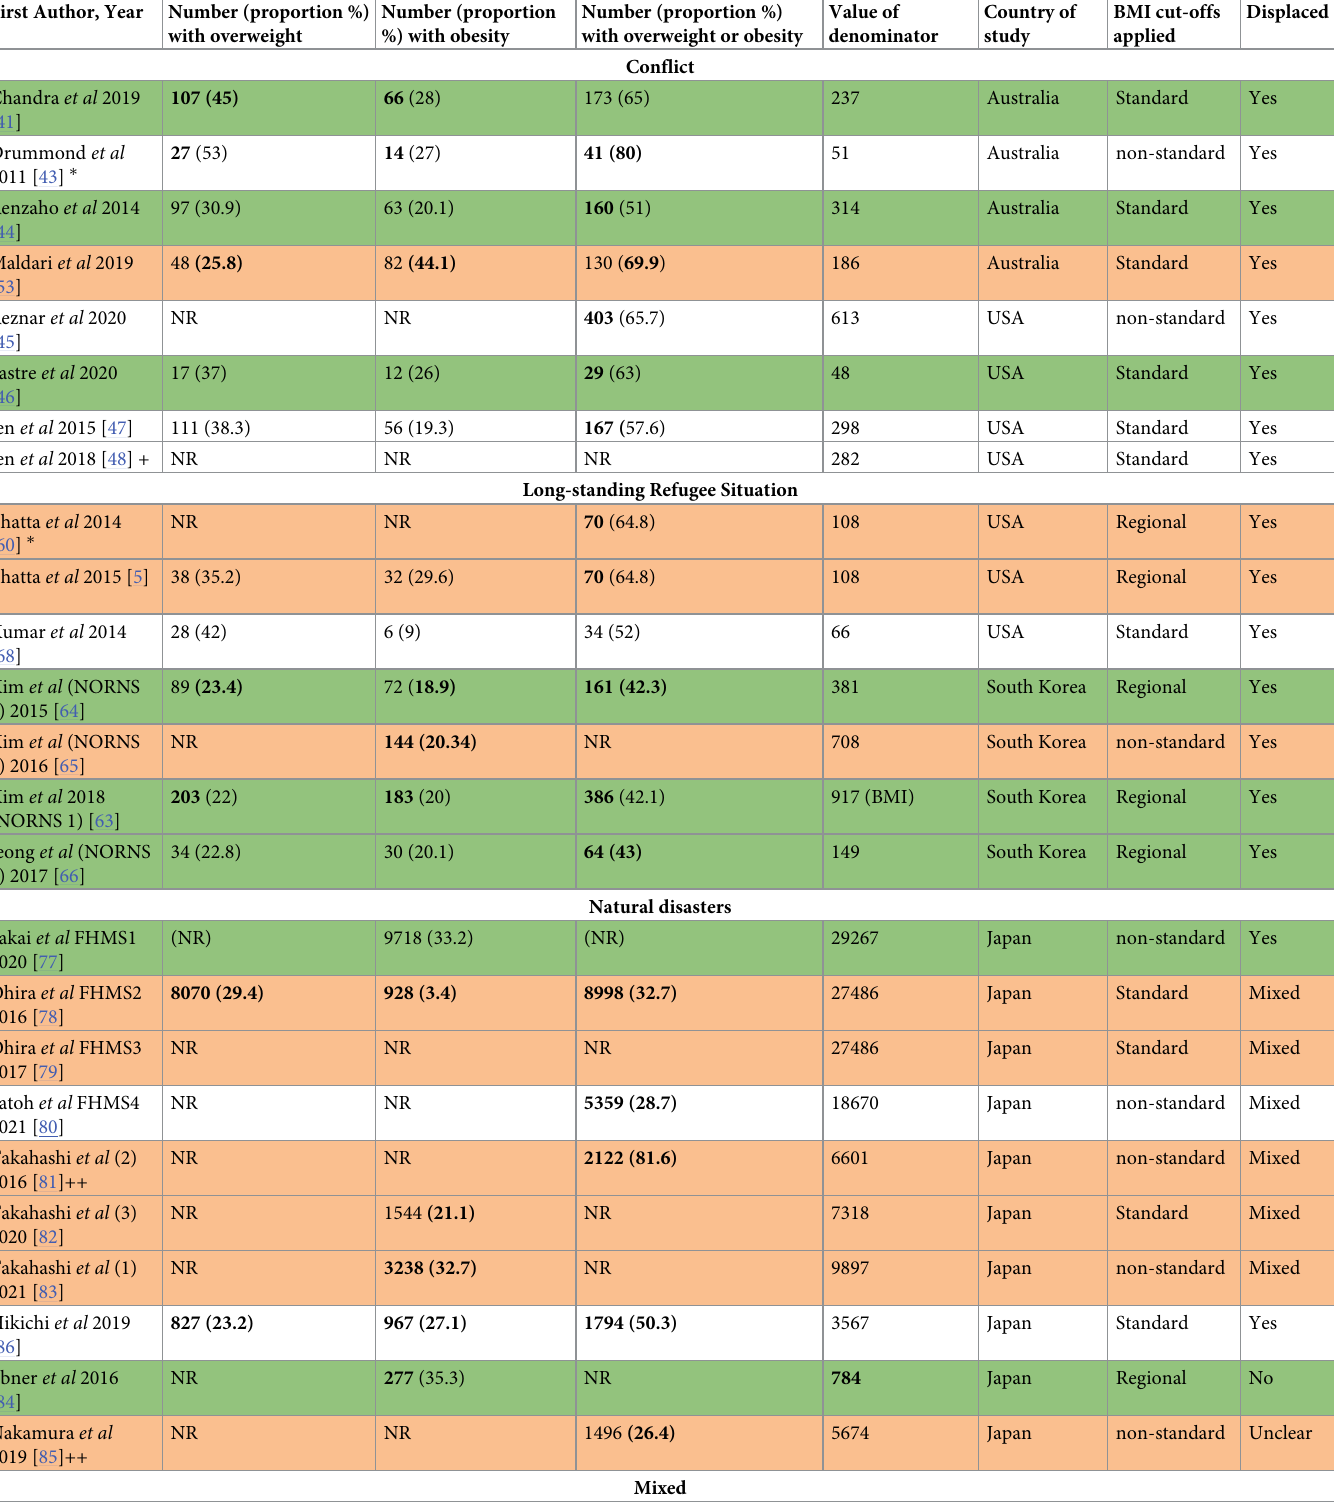
Table 3. Showing prevalence of overweight and obesity in studies carried out in high income countries. First Author, Year Number (proportion %) with